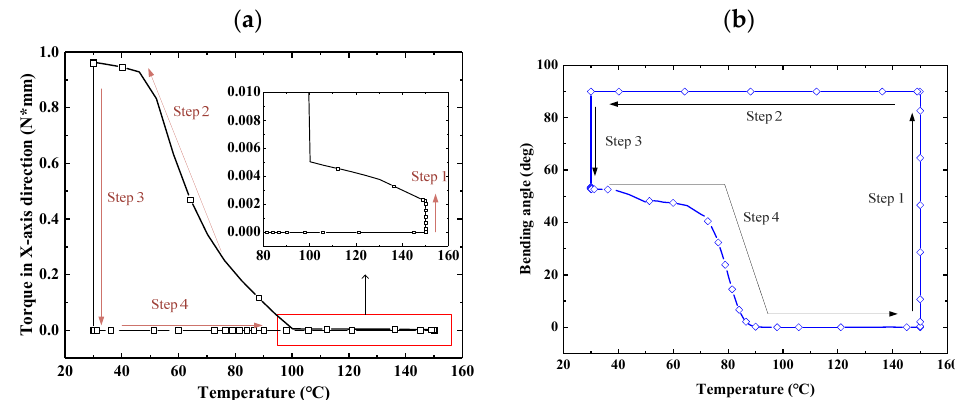
Figure 18. Response characteristic curves for E-SMP: ( a ) temperature–time curve; ( b ) bending angle–time curve.